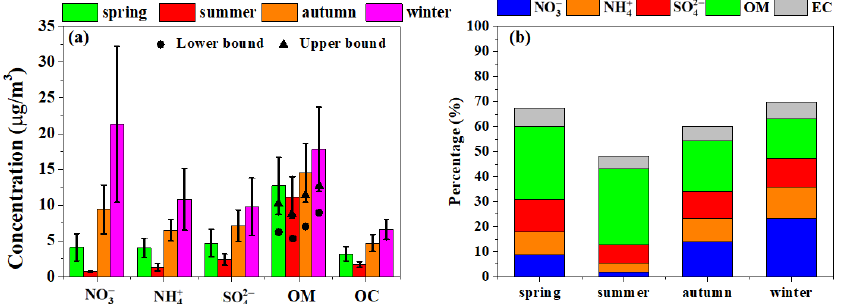
Figure 2. ( a ) Concentrations and ( b ) relative contribution of NO − 3 species during the sampling periods of different seasons. The circle and triangle dots represent the lower and upper bounds of WSOM concentrations.